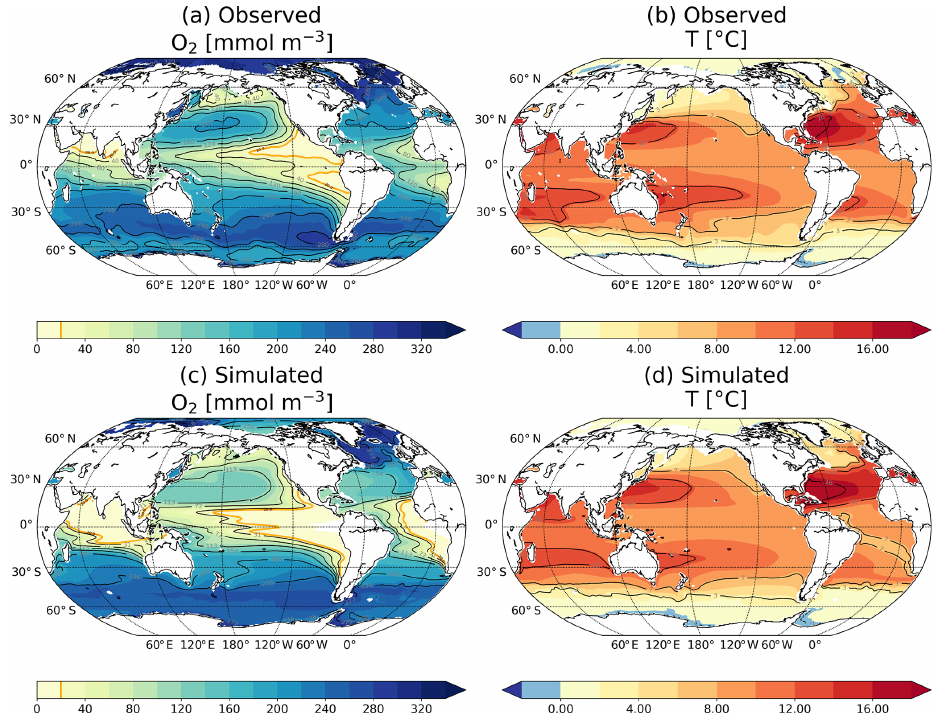
Figure A2. Observation-based (a, b) versus simulated ( c, d ; 1986–2005) oxygen concentration (a, c) and temperature (b, d) in the thermocline (200–600m). Data are from (a) Garcia et al. (2014) and (b) Locarnini et al.